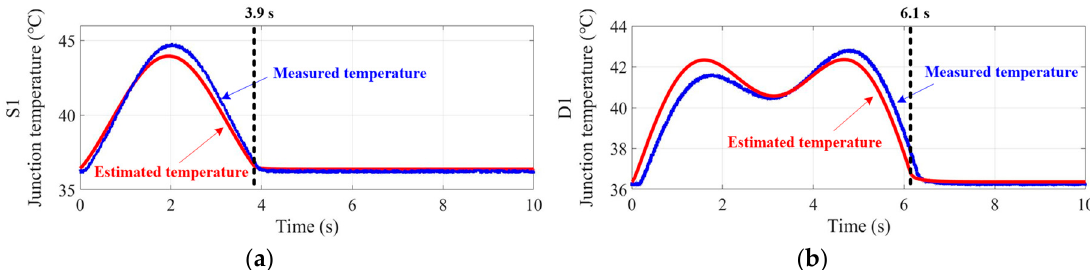
Figure 16. Measured and simulated temperature results by the load current (frequency = 0.1 Hz, amplitude = 20 A and DC offset = 7 A). ( a ) Junction temperature of S 1 ; ( b ) Junction temperature of D 1 .